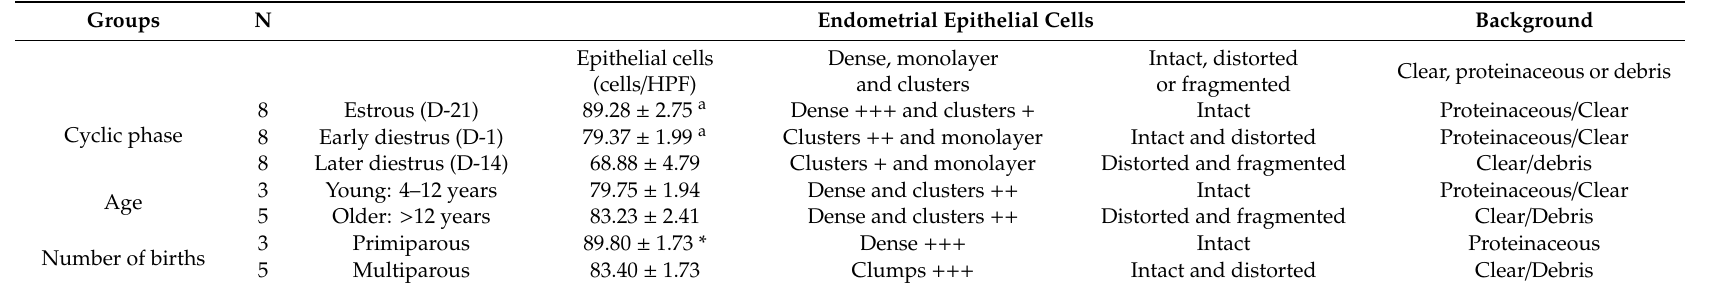
Table 2. Endometrial epithelial cellular count (Mean ± SD) in